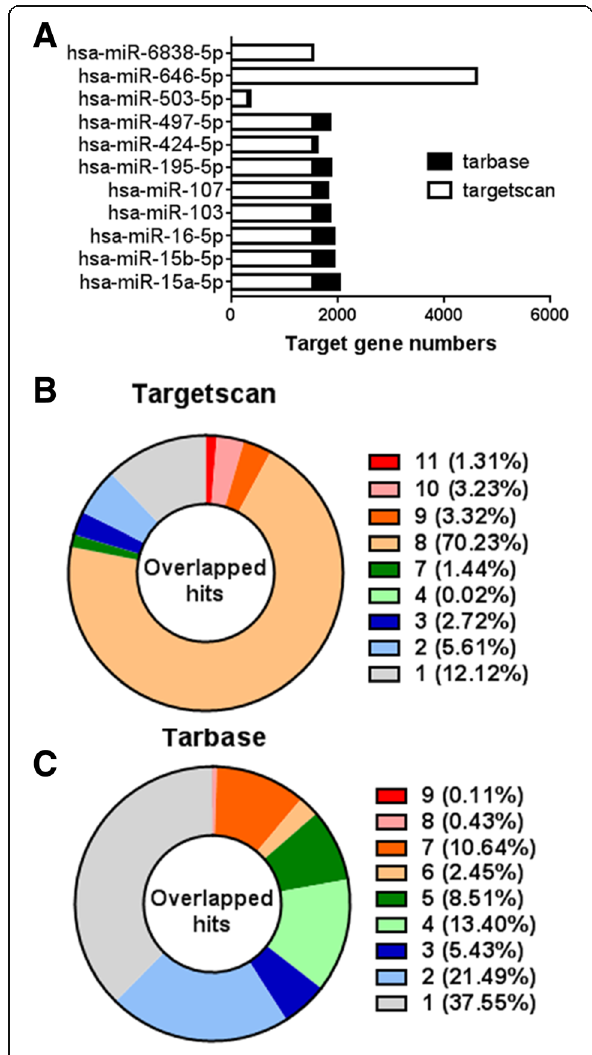
Fig. 1 Intersection of miR-15/107 regulated target genes. a . Numbers of computationally predicted (archived in Targetscan database) and experimentally validated (archived in TarBase database) target genes. b . Computationally predicted target genes regulated by multiple miR-15/107 members. c . Experimentally validated target genes regulated by multiple miR-15/107